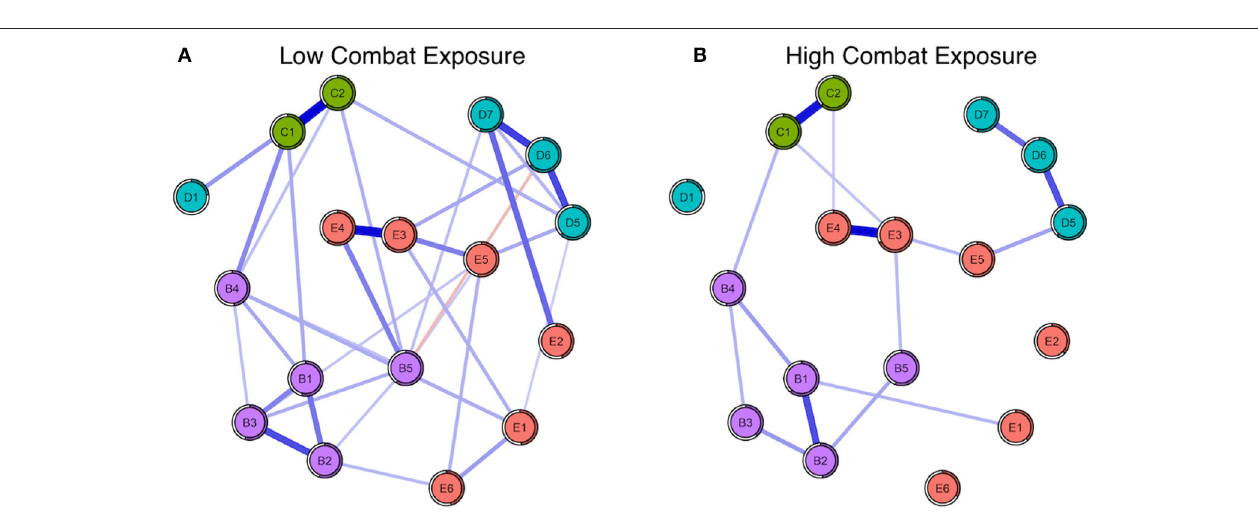
FIGURE 4 | (A) Seventeen-node DSM-IV PTSD symptom network comparison for low (left) and (B) high (right) combat exposed groups. The shaded ring around each node represents its